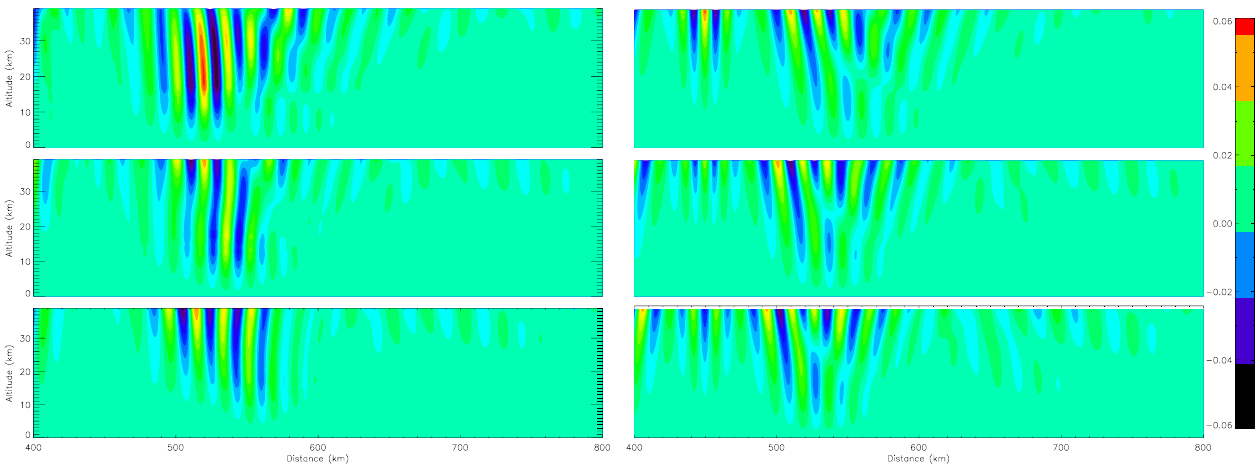
Fig. 5. Vertical velocity simulation results. The left column shows the results of the simulation with a Doppler duct located at ∼ 15km for three progressively increasing time intervals of 12000s/3.33h, 14000s/3.89h, and 16000s/4.44h. The right column shows the results from the simulation without a Doppler duct at the same time intervals. Color-bar units are in ms − 1 .